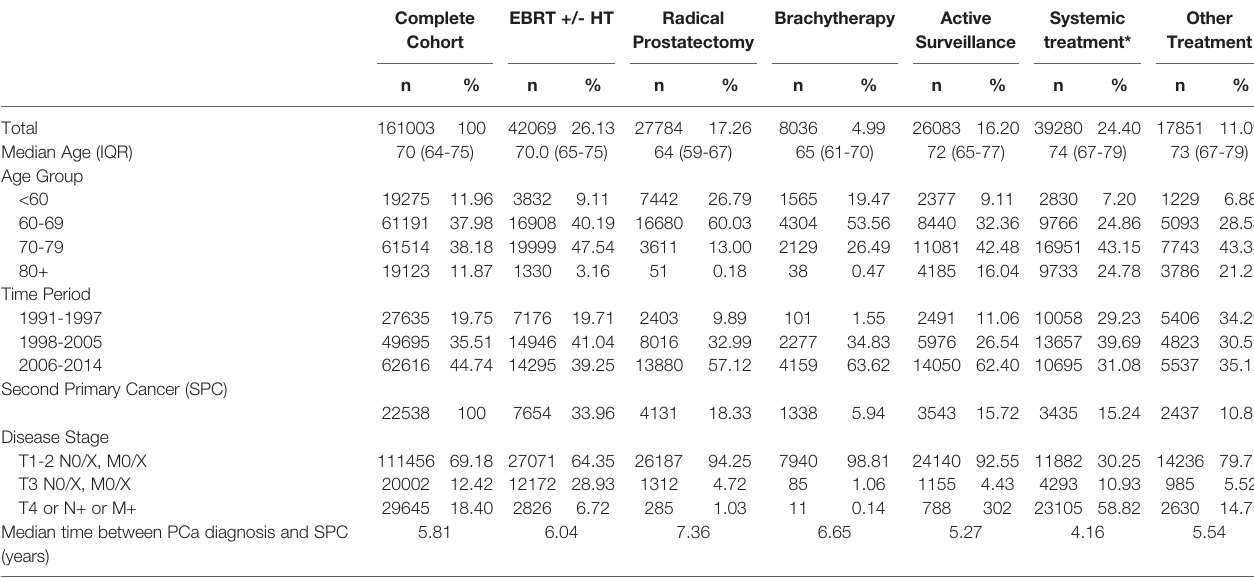
TABLE 1 | Patient and tumor characteristics for the complete cohort and per treatment modality.